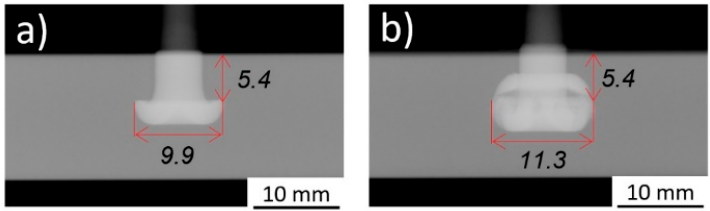
Figure 12. X-ray tomography of: ( a ) Condition 15 (RS = 18,000 rpm; FT = 2 s; FoT = 2 s; FF = 3000 N; FoF = 3900 N); and ( b ) Condition 12 (RS = 20,000 rpm; FT = 2 s; FoT = 1 s; FF = 3000 N; FoF = 3900 N).